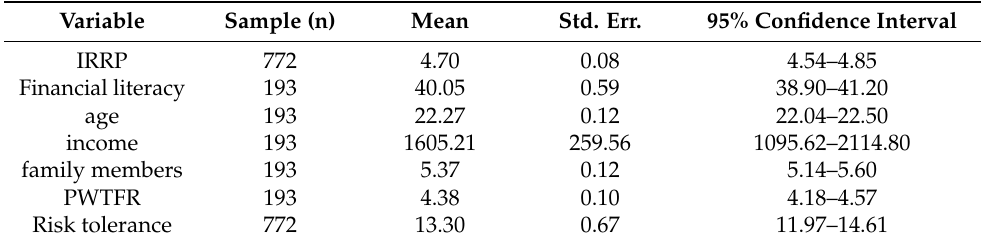
Table 3. Descriptive statistics.